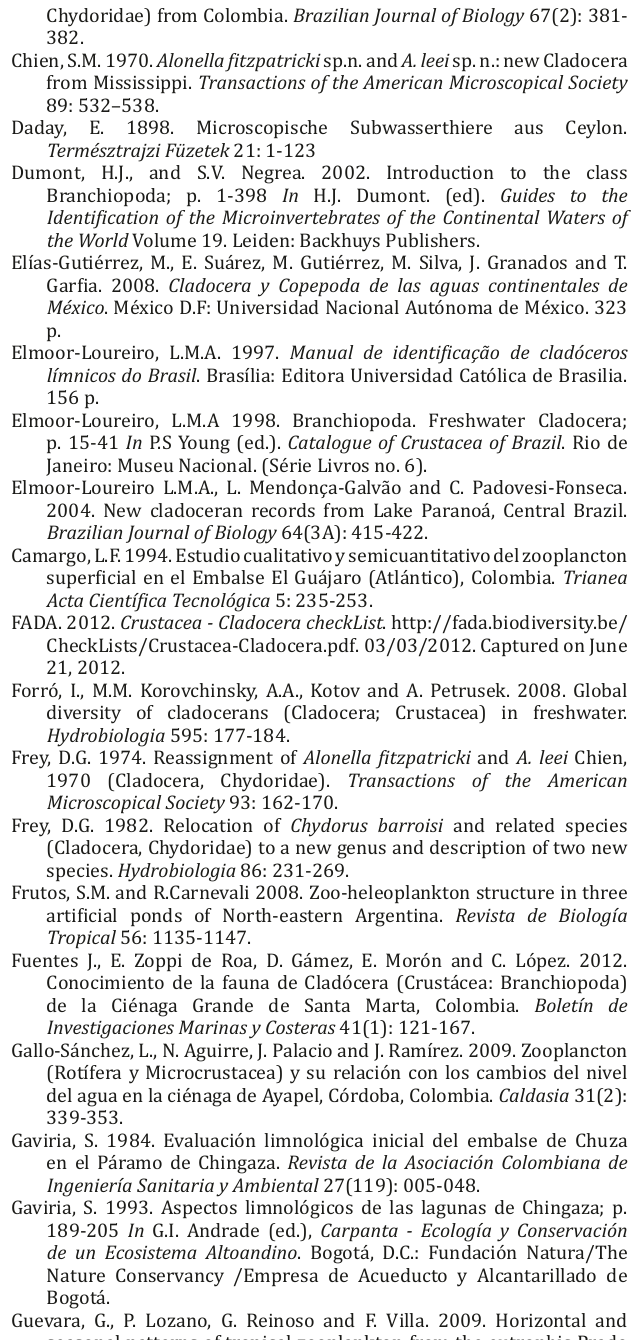
A. Postabdomen. B. Postabdominal